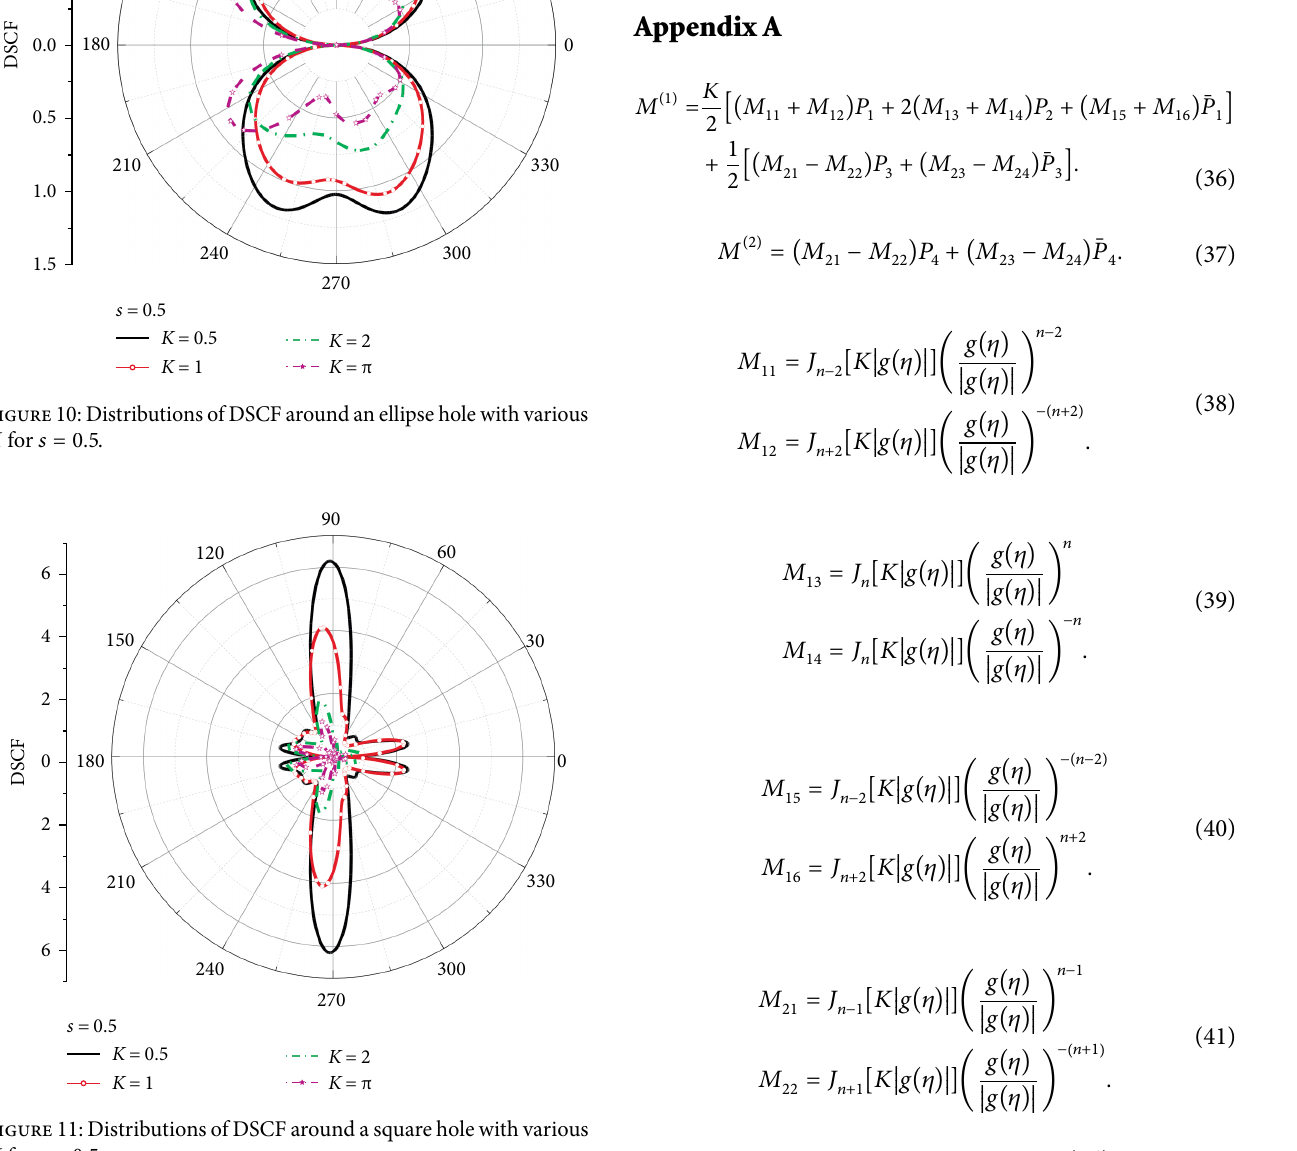
Figure 11: Distributions of DSCF around a square hole with various 5 𝐾 for 𝑠 = 0.